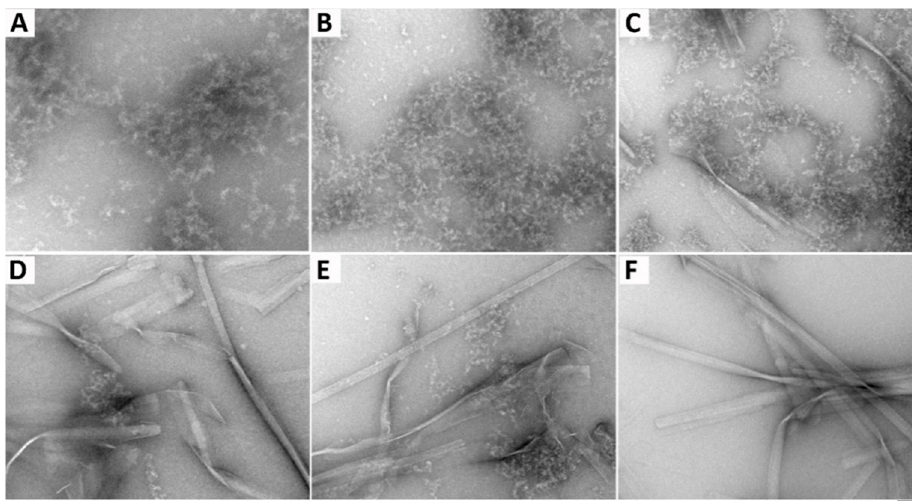
Figure 6. TEM images of 0.4 wt% NapFFDALDLTD ( 4 ) ( A ) without or with the addition of ( B ) 0.5, ( C ) 1, ( D ) 2, ( E ) 3, and ( F ) 4 equiv. (molar ratio) AcKKFKLKL ( 1 ). Scale bar is 100 nm.